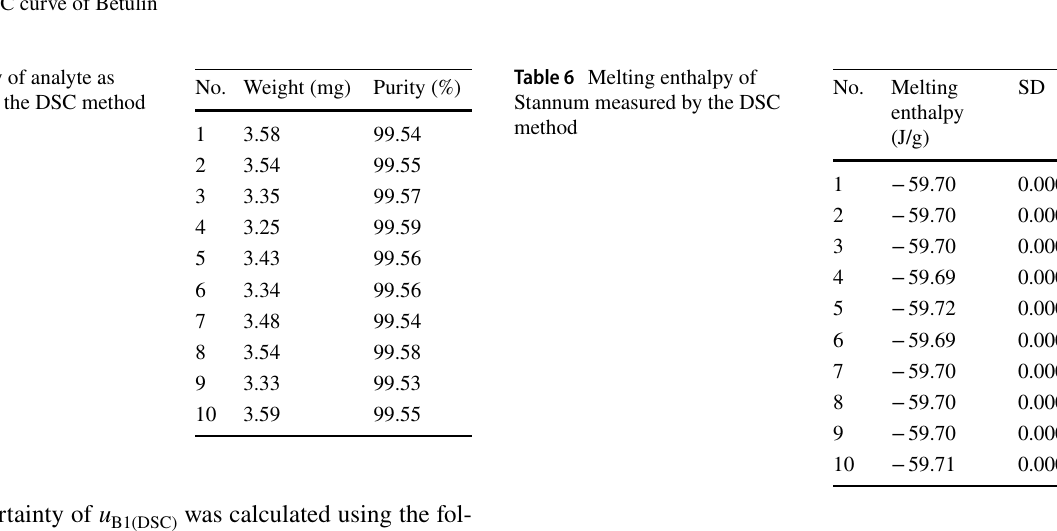
The uncertainty of u lowing expression: